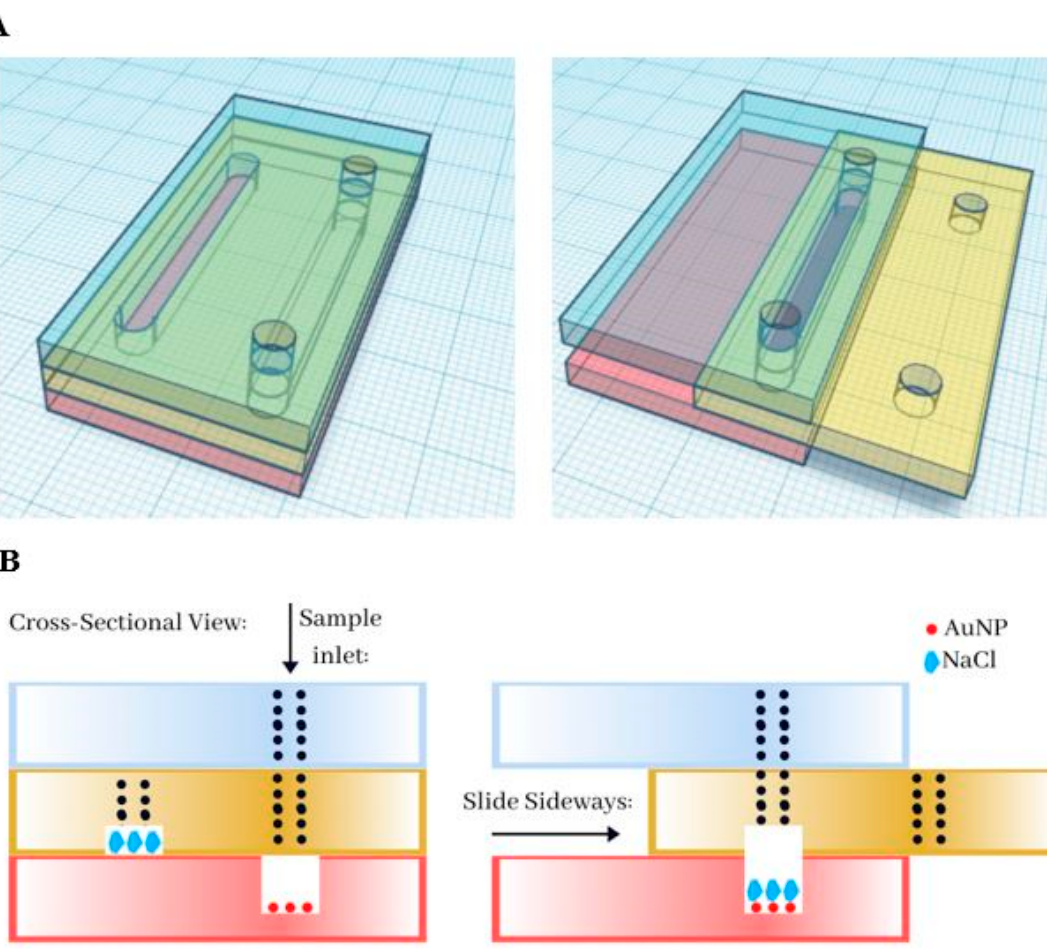
Figure 4. A Slip Chip manipulation schematic and its operating slots for fluidic function. ( A ) Side view of the Slip Chip assembly before and after salt addition. Top layer (in blue) is the sample inlet and the railing to keep bottom layers in place; Middle layer (in yellow) sample inlet flow line connecting to the bottom layer. The middle channel is prefilled with an oversaturated solution of NaCl. Bottom layer (in red) contains another channel, prefilled with AuNPs that were fixed to the surface using starch hydrogels. ( B ) When all three layers are in place and aligned, the sample is injected through the Sample Inlet, and then, incubated with the nanoparticles for 3 min. After the incubation step, the middle layer slides sideways to allow the salt reservoir to get in contact with AuNPs and the sample